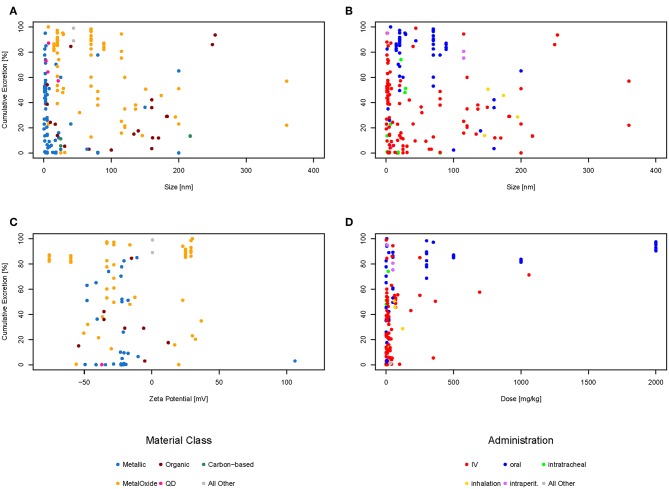
Cumulative excretion vs. size of nanoparticle color-coded by material class (A), cumulative excretion vs. size of nanoparticle color-coded by type of administration (B), cumulative excretion vs. zeta potential of nanoparticle color-coded by material class (C), and cumulative excretion vs. dose of nanoparticle color-coded by type of administration (D).